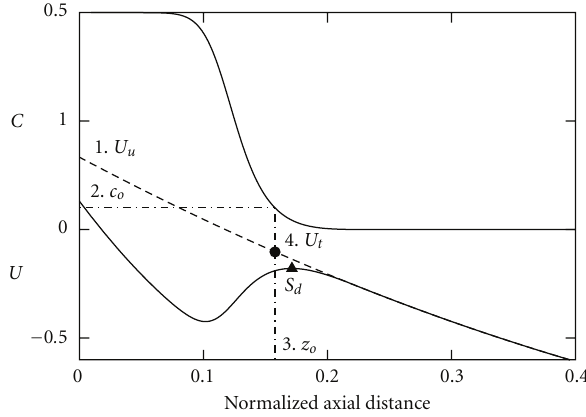
Figure 6: Tested method for determining turbulent burning velocity. Bold and thin solid lines show typical axial profiles of the Favre-averaged combustion progress variable and normalized axial velocity, respectively. Dashed curve calculated using (14) extrapolates the mean velocity profile from the oncoming flow to the flame brush. Filled circle shows turbulent burning velocity determined using the tested method. Filled triangle showsturbulent displacement speed associated commonly with the local minimum of | (cid:6) w ( z ) |